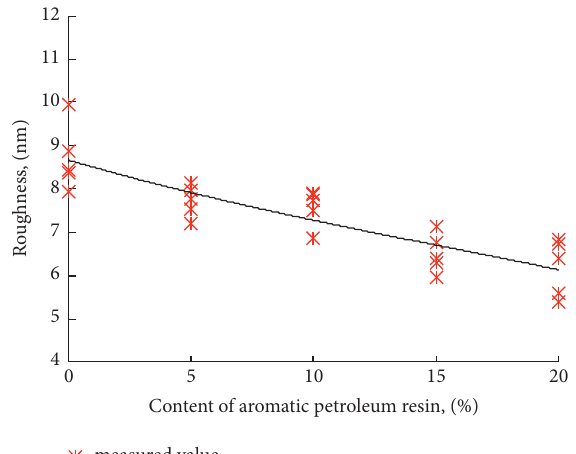
Figure 17: The roughness of SBS modified asphalt with different APR contents.